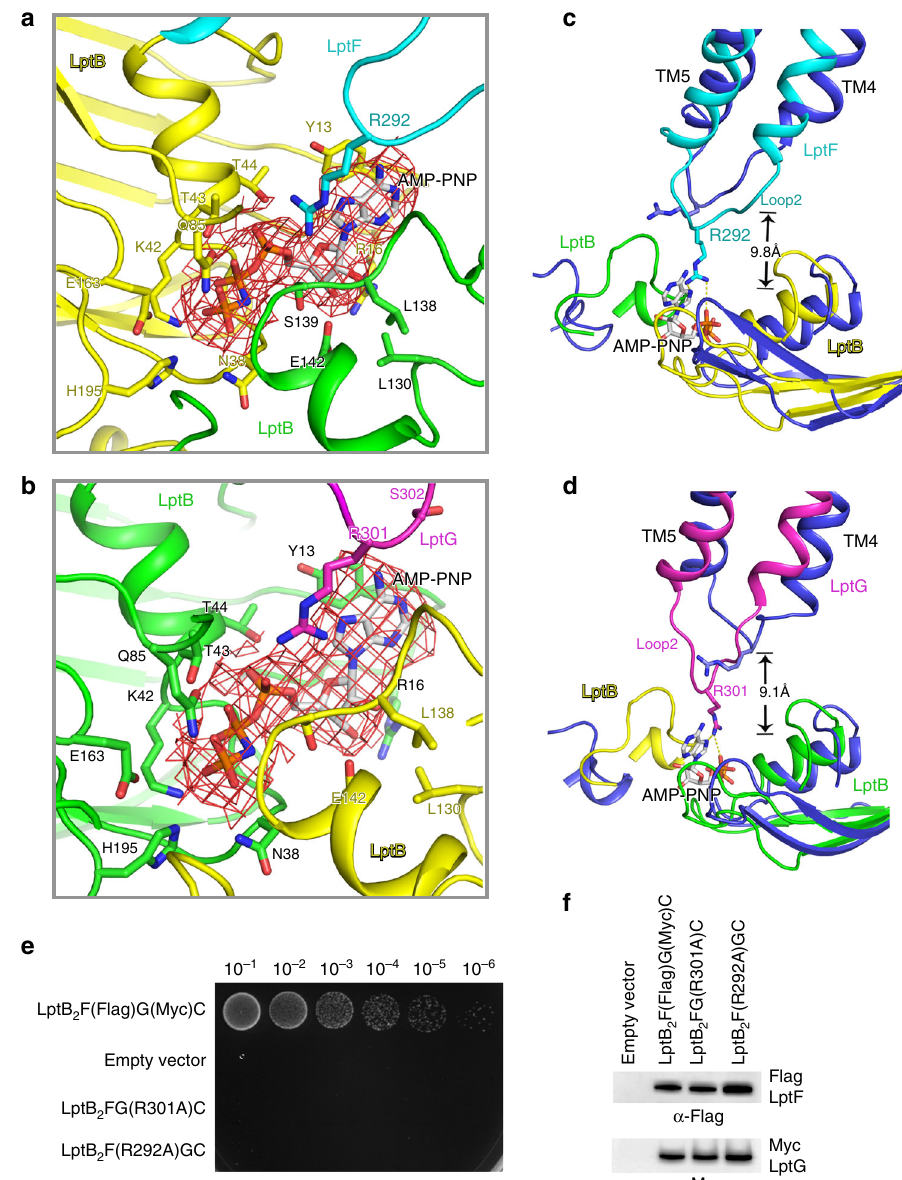
Fig. 6 R292 of LptF and R301 of LptG are involved in AMP-PNP binding. a A close view of AMP-PNP binding residues with dimeric LptB and R292 of LptF. b A close view of AMP-PNP binding residues with dimeric LptB and R301 of LptG. AMP-PNP molecules are shown in stick, and the cryo-EM map for AMP- PNP are shown in red mesh. c The two cryo-EM structures are superimposed. The arginine residue R292 located on the cytoplasmic loop 2 of LptF shifts around 9.8 A ̊ to interact with AMP-PNP. d The arginine R301 located on the cytoplasmic loop 2 of LptG shifts around 9.1 A ̊ to interact with the AMP-PNP. AMP-PNP molecules are shown in stick, the colour scheme of sf LptB 2 FGC AMP-PNP bound is the same as in Fig. 4, and sf LptB 2 FG LPS bound is coloured in blue. e Functional assays of the single mutants R292 of LptF and R301 of LptG. NR1113 cells were transformed with empty vector (pTRC99a_Kan, the negative control) or the vector encoding LptB 2 F(Flag)G(Myc)C (the positive control). f Detection of protein expression levels of mutants by western blotting. Empty vector (pTRC99a_Kan, the negative control) or the vector encoding LptB 2 F(Flag)G(Myc) (the positive control). The bacterial cells for western blotting were cultured in the presence of 0.2% L -arabinose. All results have been con fi rmed at least three times. Source data are provided as